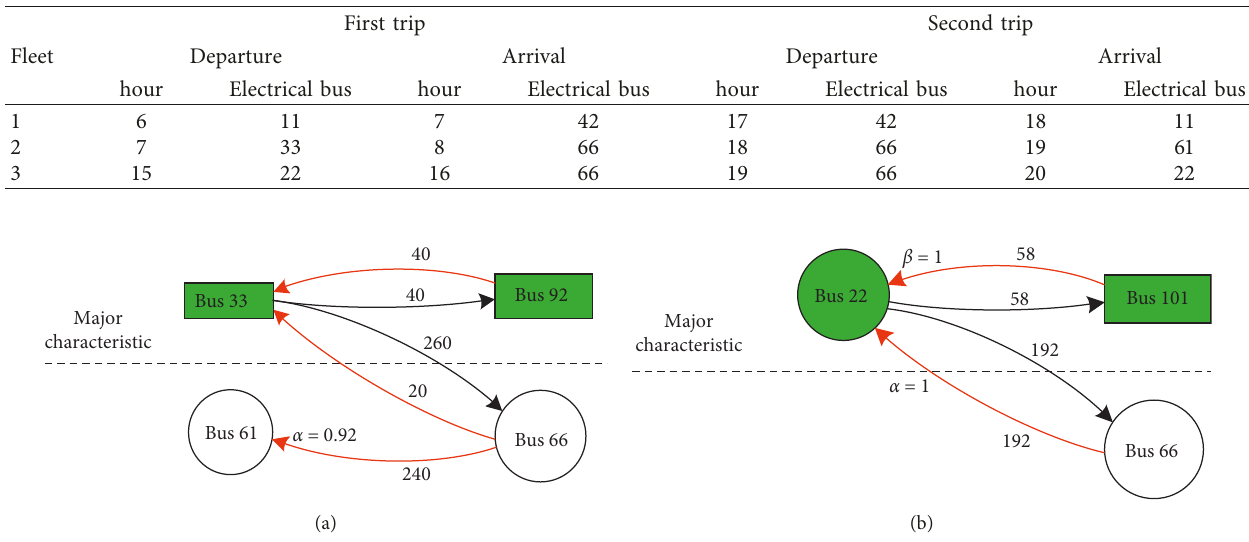
Figure 14: Travel characteristics considering the restored PLs (a) fleet 2; (b)